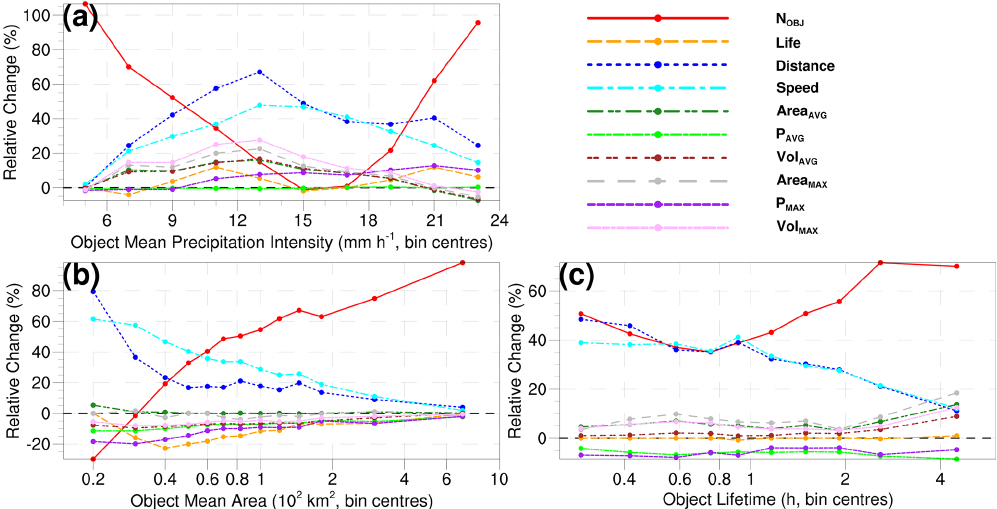
Figure 9. Ensemble mean projected change (%) in object characteristics under the RCP8.5 scenario as a function of (a) object intensity, (b) object area and (c) object lifetime. Note the logarithmic x axes in panels (b) and (c) . In panels (a) , (b) and (c) , P min , A min and T min are set at 4.5mmh − 1 , 2 grid boxes and 15min, respectively, while the remaining thresholds are in each case set to their reference values. For visual clarity, results are based solely on the ADV algorithm. As in the rest of the paper, results are for median values. Each bin has a minimum of 50 data points in at least 15 of the 18 ensemble members; members with less than this total are not considered in the